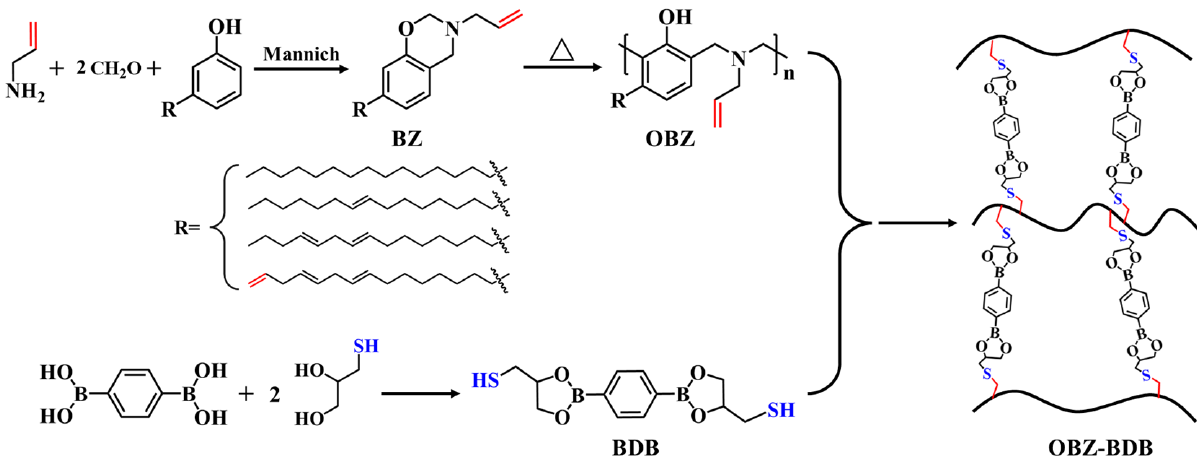
Figure 2. 1 H NMR spectra of allylamine ( a ), cardanol ( b ), BZ monomer ( c ), and OBZ ( d ).